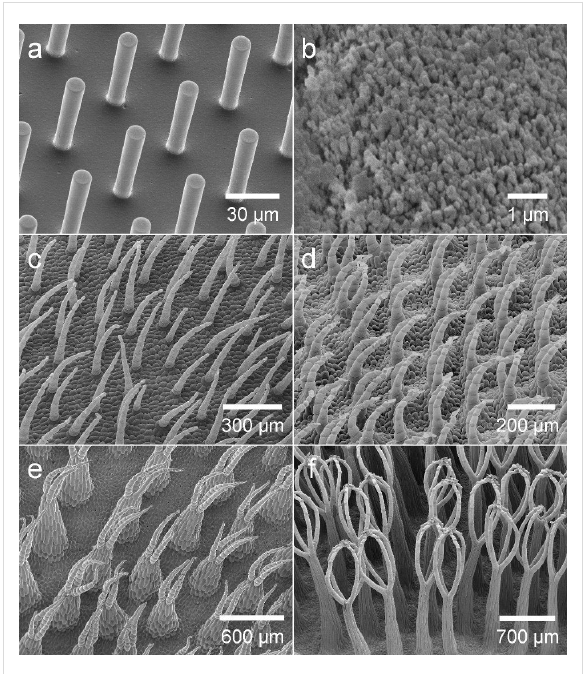
Figure 4: SEM images of technical and biological microstructured surfaces used for air volume measurements. a) uncoated epoxy-resin replica of a silicon wafer with pillars of 10 µm diameter and 60 diago- nal pitch, b) hydrophobic coating of the replicas with Tegotop 210